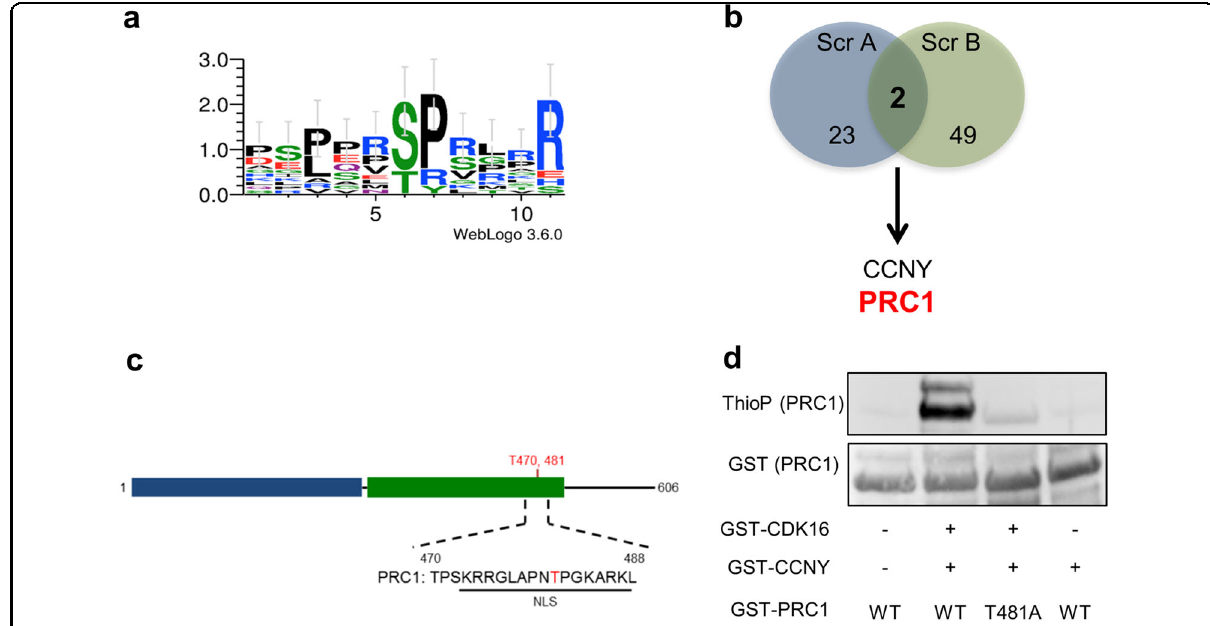
Fig. 3 Identi fi cation of PRC1 as a direct substrate of the CDK16/CCNY complex. a The CDK16 phosphorylation consensus sequence was identi fi ed using WebLogo. b The Venn diagram of selected CCNY interactors (Screening A, Scr A) and CDK16/CCNY direct substrates (Screening B, Scr B) illustrates that PRC1 is the only substrate identi fi ed by both approaches. c Schematic representation of the human PRC1 locus showing the NLS domain where Thr481 is located. d In vitro kinase assay using WT-GST-CDK16, GST-CCNY and either WT or T481A-mutant of